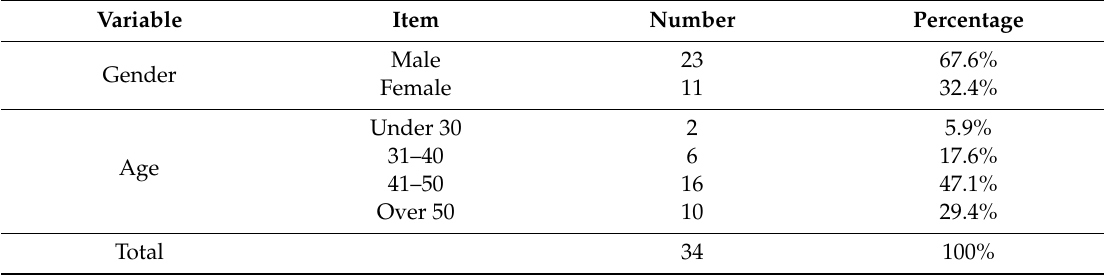
Table 8. Demographic distribution for the face-to-face (FtF) communication control group.